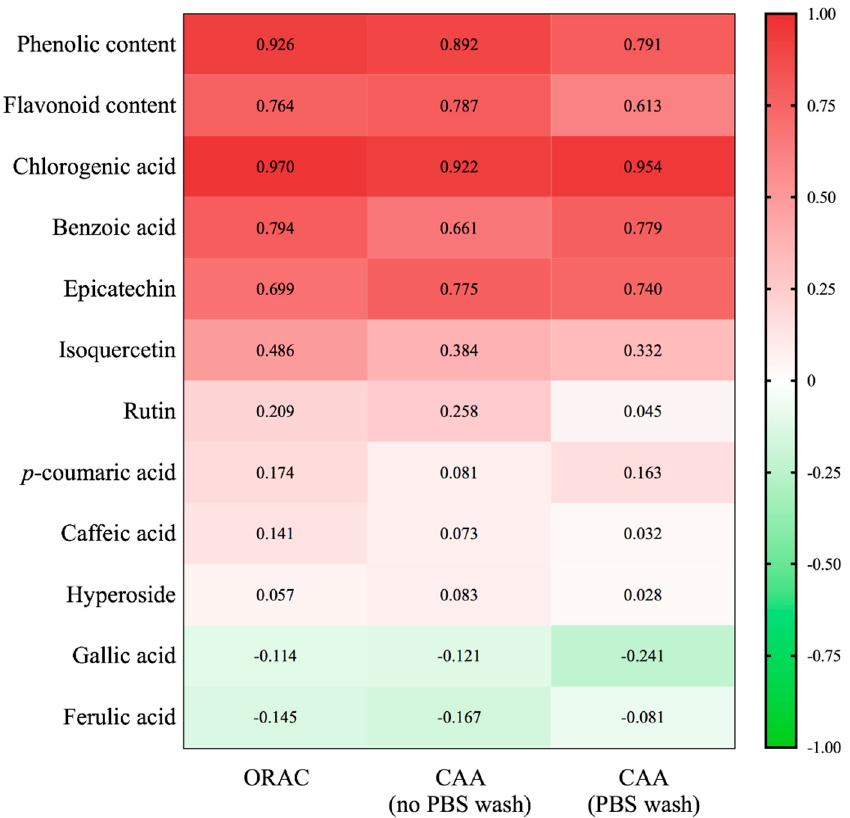
Figure 6. Heat map of Pearson`s correlation coefficient among phenolics and ORAC, CAA in no PBS wash and PBS wash protocols. Gradient color barcodes at the left indicated the minimum value in green and the maximum in red.